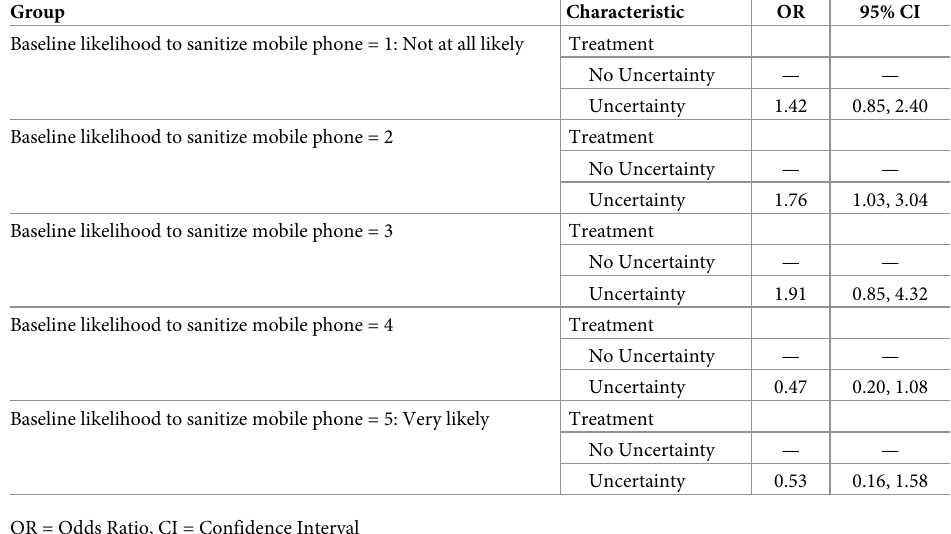
baseline if they responded with 1, 2, or 3. Here, we examine how sensitive the results are to this cutoff. Table 3 shows the model stratified by the participants’ response without dichotomizing, resulting in 5 separate proportional odds models fit. The point estimates of the results appear consistent with the main result. The models where the participant responded that they were less likely to sanitize their phone at baseline (indicated by a response of a 1, 2, or 3) have odds ratios greater than one, indicating that seeing uncertainty on the initial recommendation may increase the likelihood of adherence to a subsequent recommendation. The models where the Table 3. Sensitivity analysis: Proportional odds model fit stratified by baseline likelihood to sanitize mobile phone (with 5 levels). Group Characteristic OR 95% CI Baseline likelihood to sanitize mobile phone = 1: Not at all